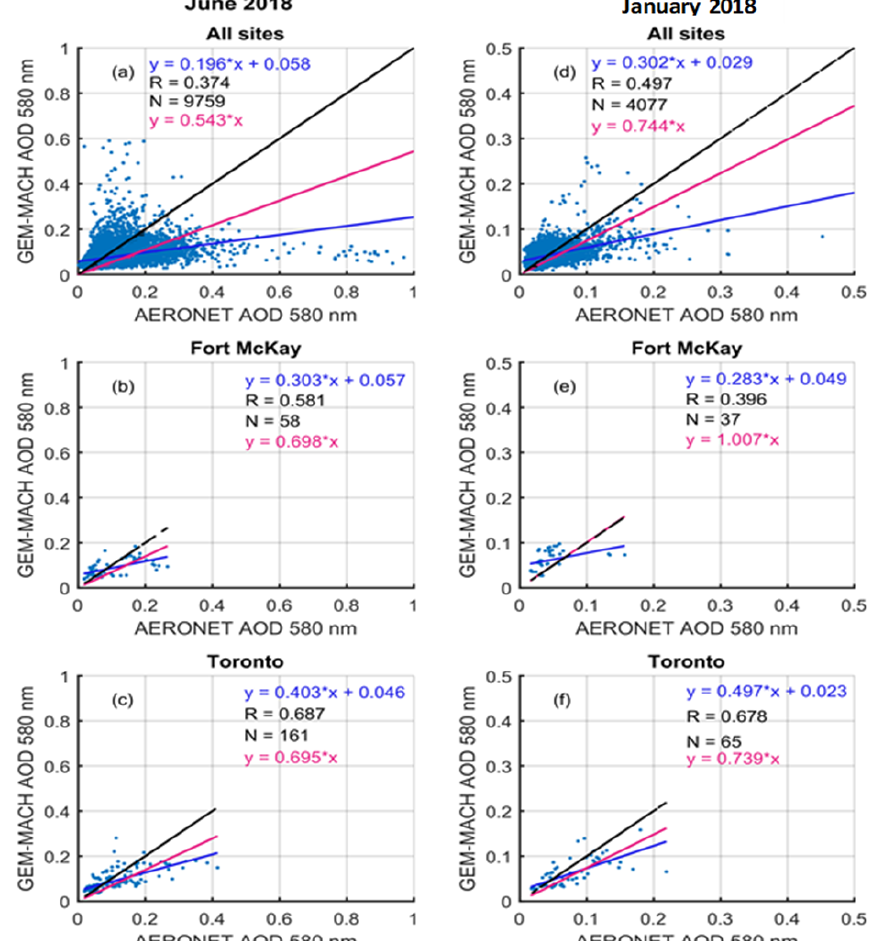
Figure 7. Scatter plots of AERONET AOD vs. GEM-MACH AOD at 580nm for all North American sites, Fort McKay (57.18 ◦ N, − 111 . 64 ◦ W) and Toronto (43.79 ◦ N, − 79 . 47 ◦ W) AERONET stations. Correlation coefficient ( R ) is calculated for the line with dynamic intercept (blue line). (a, b, c) June 2018, (d, e, f) January 2018. The blue line represents the linear fit and the red line is the zero-intercept linear fit. The 1 : 1 line is shown in